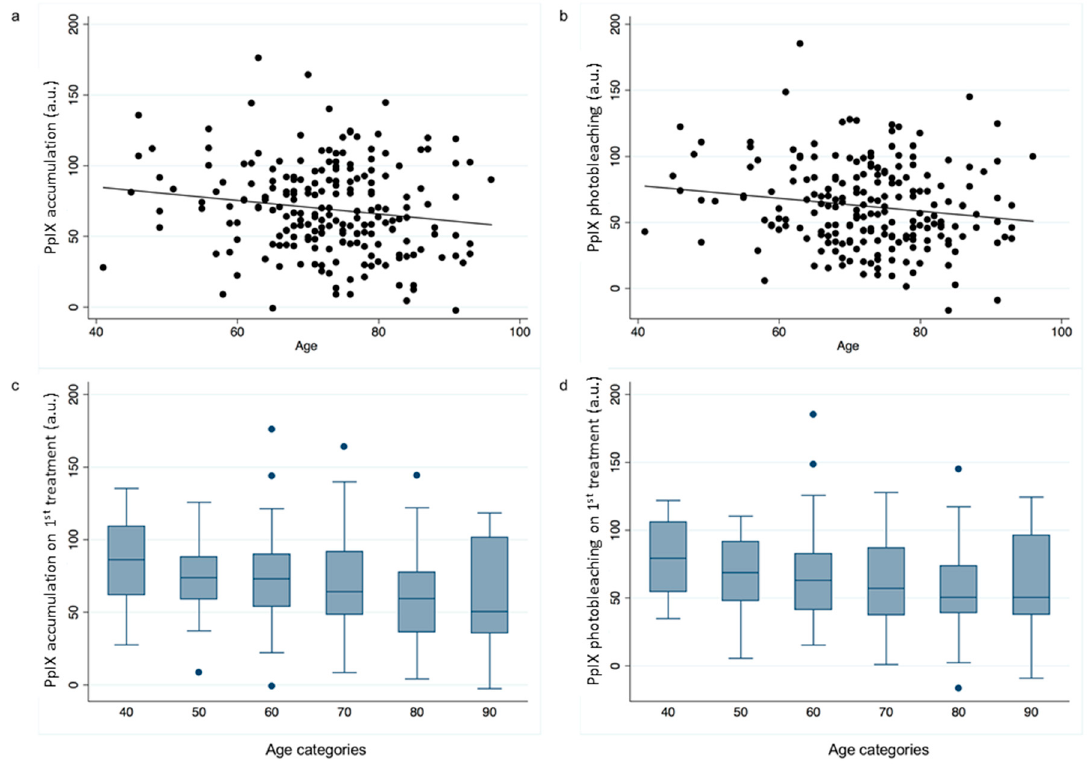
Figure 3. Scatter plots of age at treatment versus ( a ) PpIX accumulation (a.u.) and ( b ) PpIX photobleaching (a.u.) and box plots of ( c ) PpIX accumulation and ( d ) PpIX photobleaching distribution for different age categories.